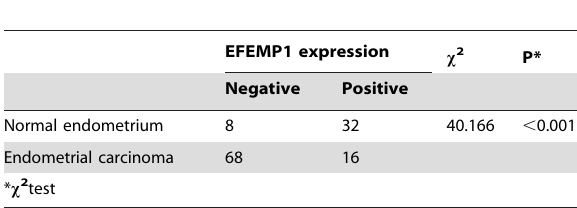
Table 1. Statistical difference between EFEMP1 expression in normal endometrium and endometrial